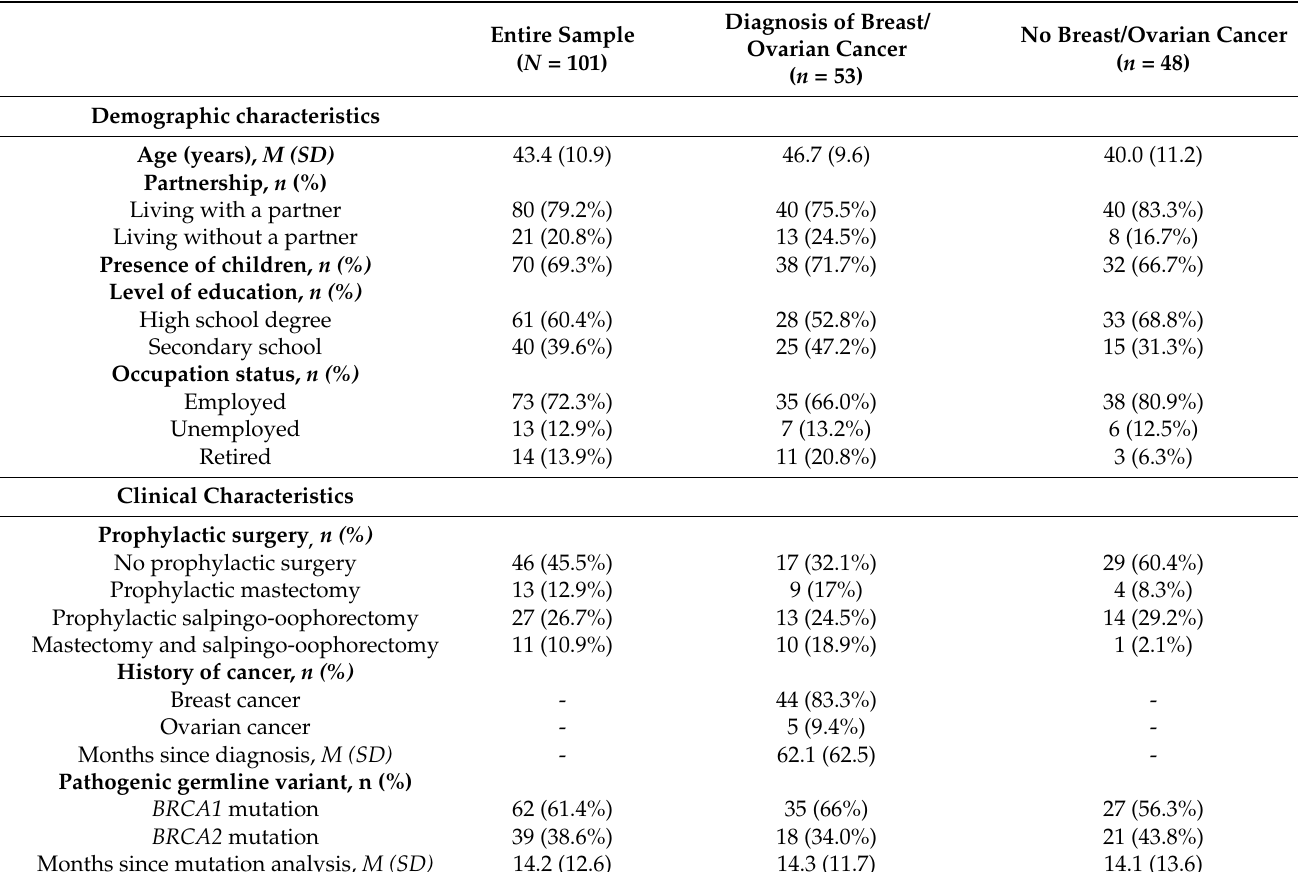
Table 1. Demographic and clinical characteristics of the entire study population and according to previous diagnosis of cancer.